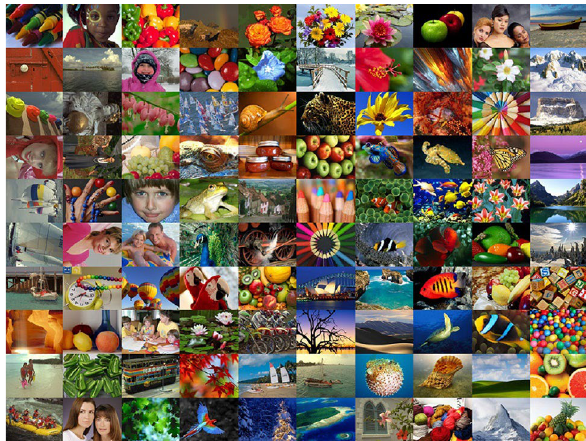
Figure 4. Dataset of color images used for the